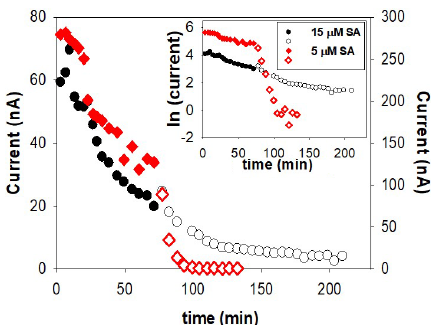
Figure 5. Reversibility of Fe–SA formation upon addition of 150nM DTPA at t = 80min. The experiment was undertaken with a Metrohm electrode in-cell in UV-irradiated seawater with 6nMFe and two SA concentrations, 5µMSA (right-hand side y axis) and 15µMSA (left-hand side y